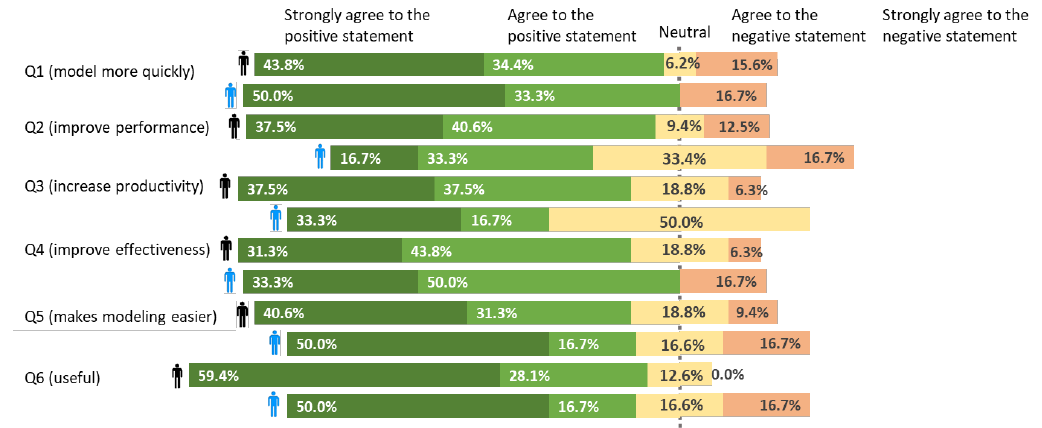
Fig. 13. Perceived usefulness of USINN for interaction and navigation modeling.